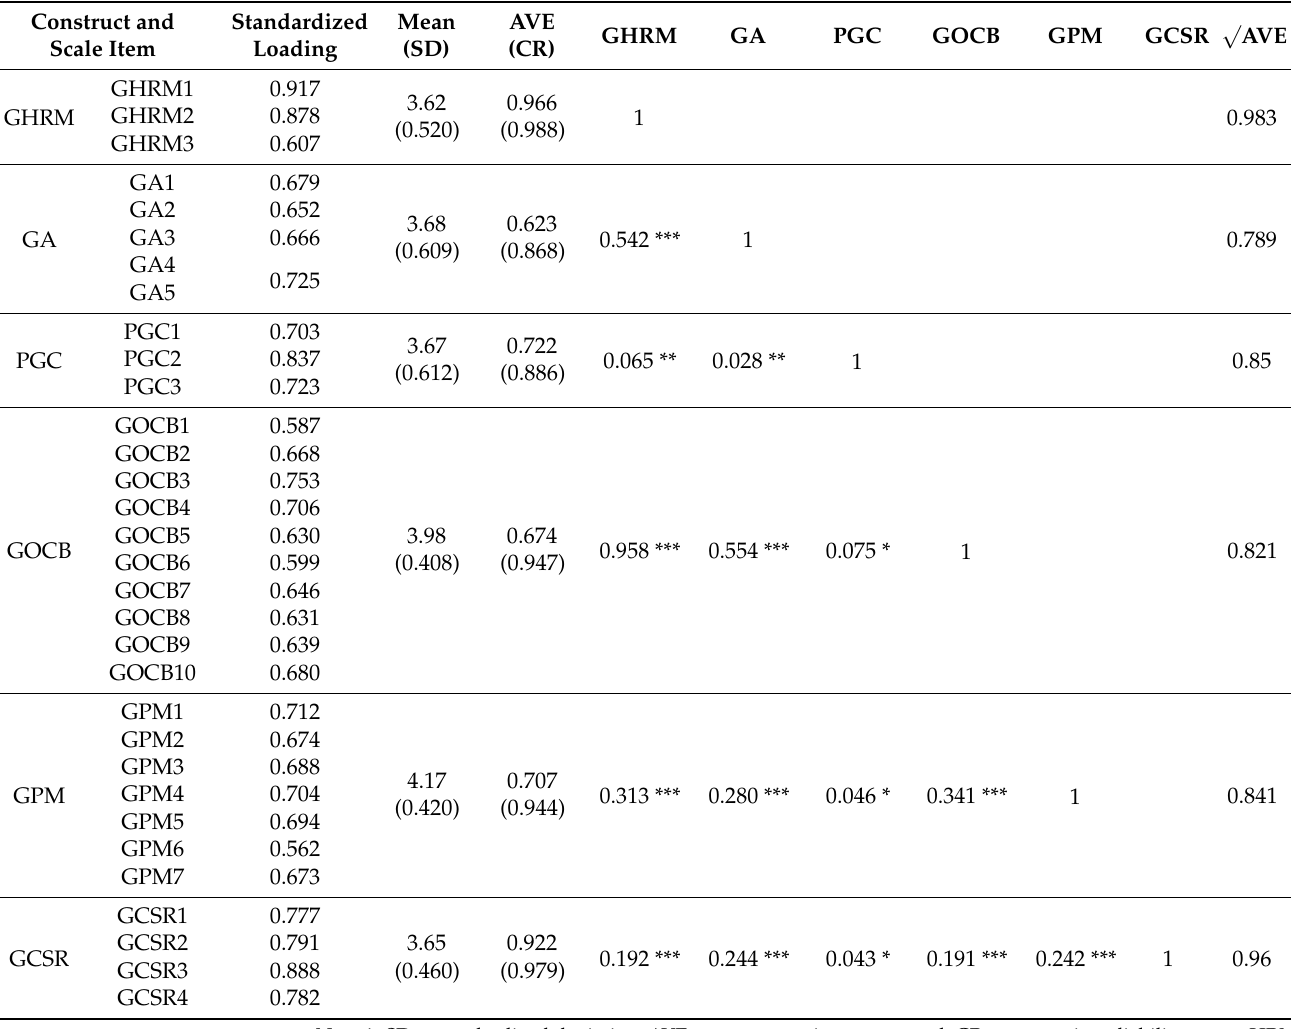
Table 1. The measurement model and